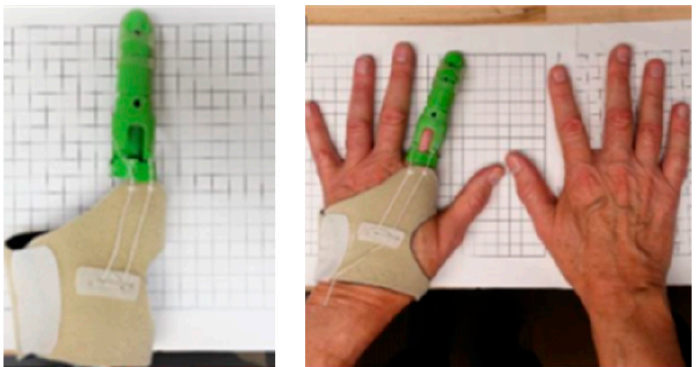
Figure 6. Examples of 3D printed antibacterial prosthetic material with a commercial filament of PLA with 1–3% copper nanoparticles, PLACTIVE TM (Image reproduced with permission from